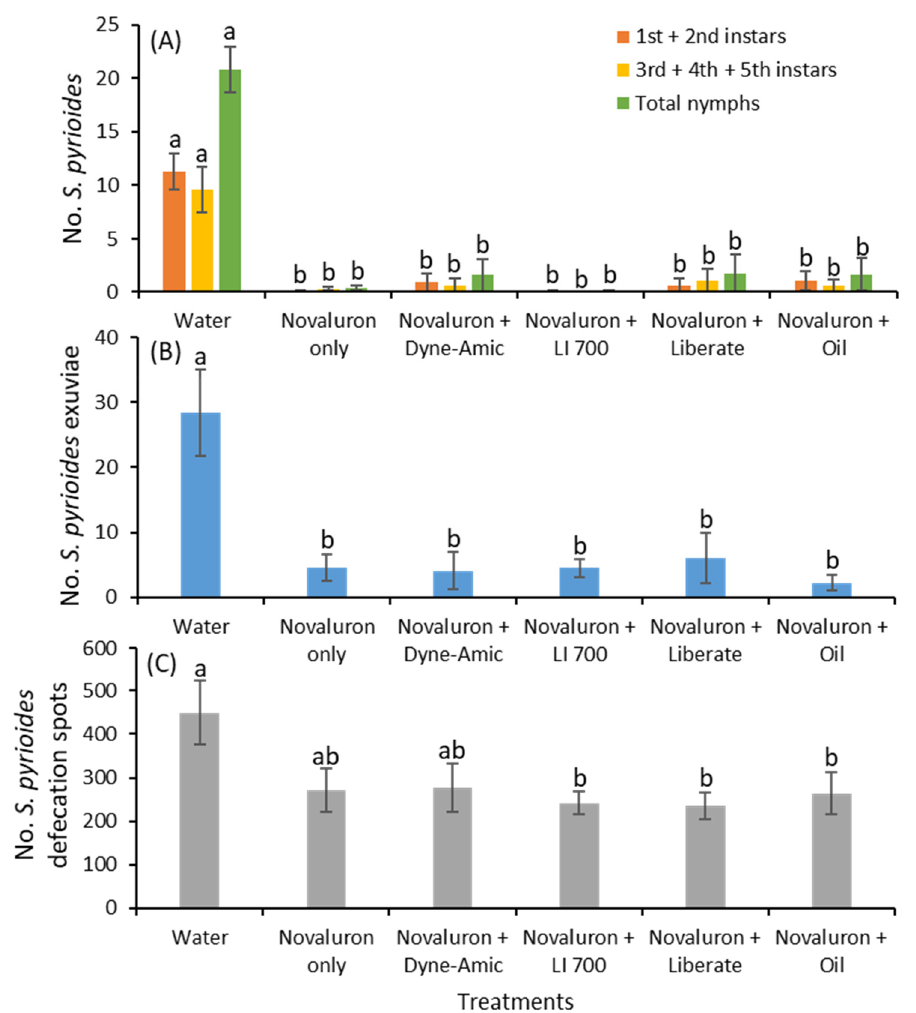
Figure 3. Mean ( ± SE) ( A ) numbers of various instars and total nymphs of S. pyrioides , ( B ) exuviae and ( C ) defecation spots after adults fed for 4 d on the abaxial leaf surface of leaves treated with novaluron and novaluron + various adjuvants on the adaxial surface. Bars with the same fill color and the same letters are not significantly different (Tukey’s HSD test, p = 0.05).